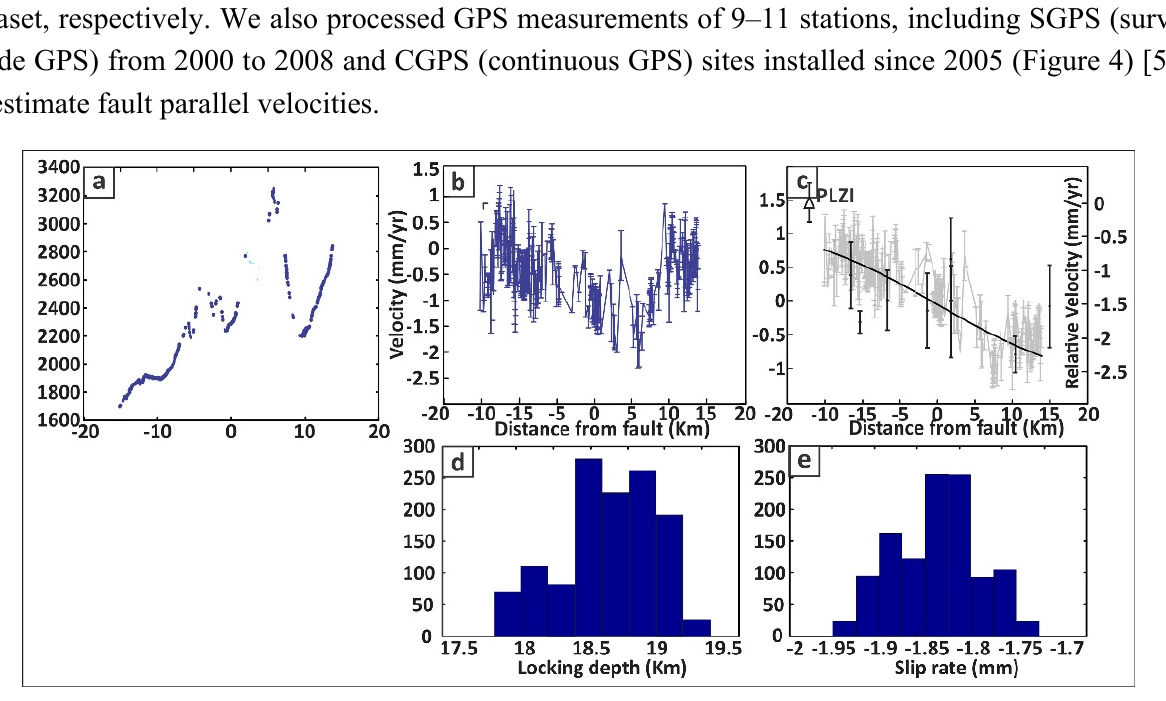
Figure 11. Fault parallel velocity profile spanning 2003–2006, along a profile shown by red dashed line in Figure 6d–f. ( a ) Topographic profile. ( b ) Stamps velocity. ( c ) ISBAS velocity and fit to deformation data using elastic half-space model. The black line shows the best fit model. The black dots are velocities obtained from GPS observations. The axis of relative velocity corresponds to fault-parallel velocity estimated from GPS observations with respect to the station PLZI (marked by black rectangle). Probability distribution for the ( d ) locking depth and ( e ) slip rate determined from the bootstrap method. InSAR-derived velocity values are relative to the profile